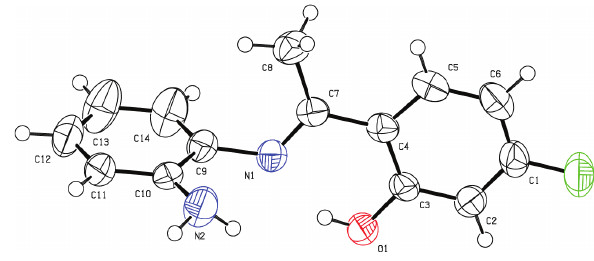
Table 1: Data collection and handling.